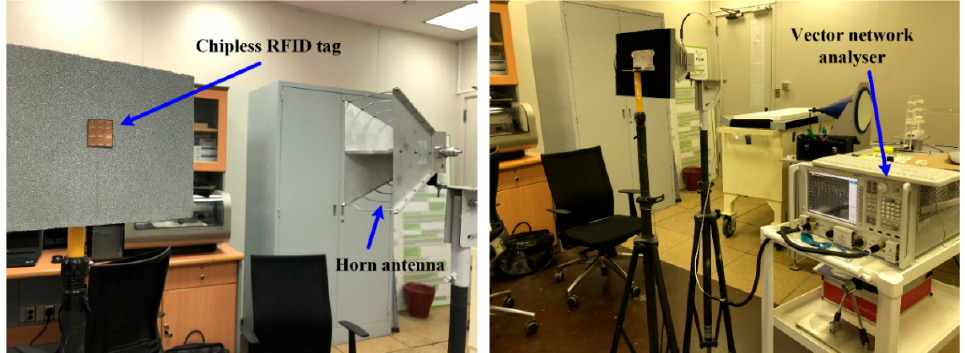
Figure 14. Monostatic measurement setup.